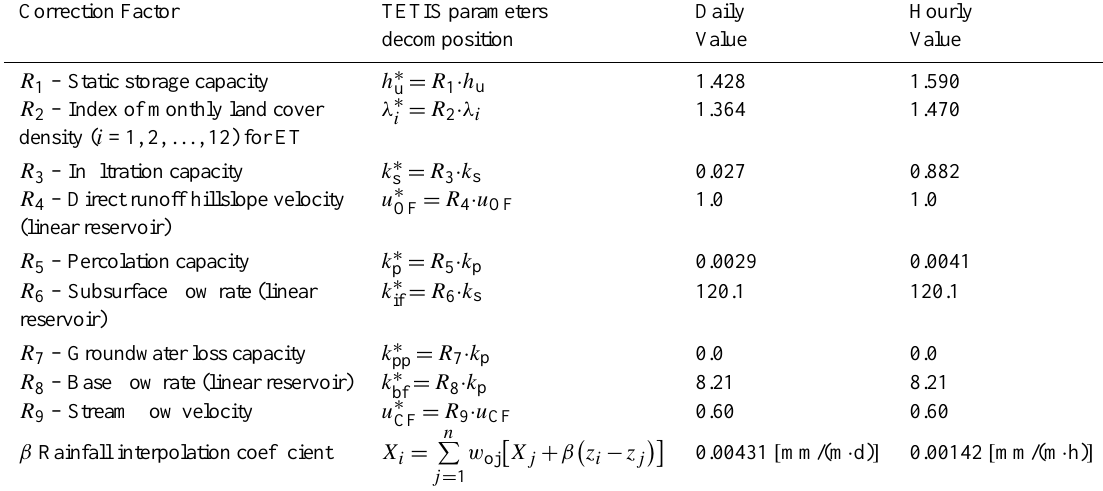
Table 3. Calibrated values of the correction factors and β coefficient with the automatic optimization algorithm for hourly and daily models. Correction Factor TETIS parameters Daily Hourly